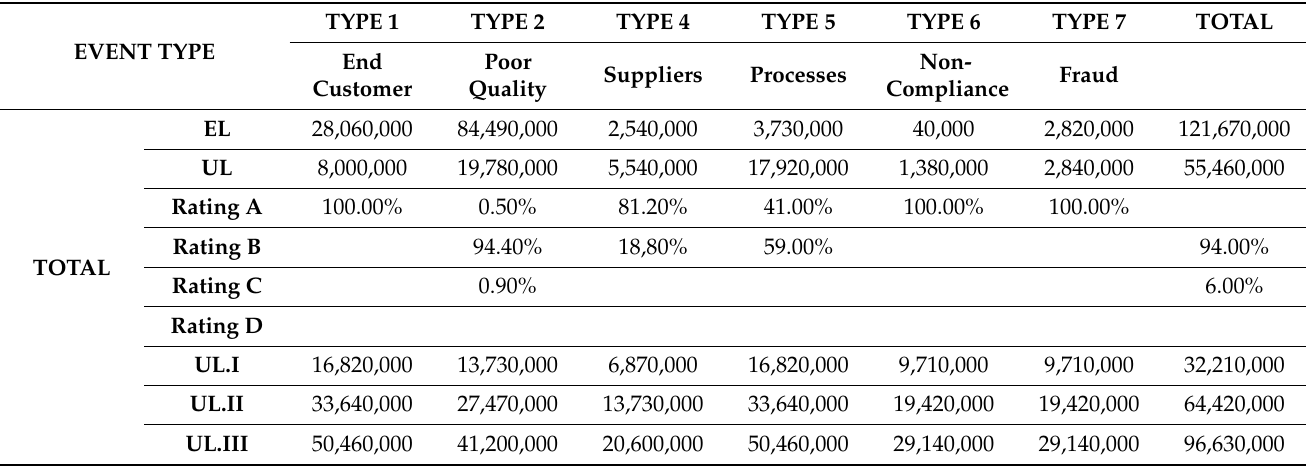
Table 5. Results of Residential organizational